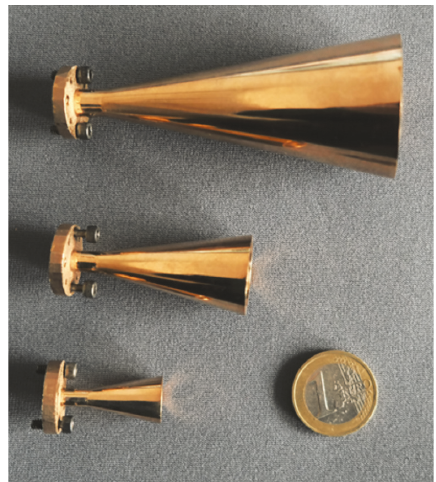
Figure 3: 3D printed horns antennas, from top E-, D-, and H-band.